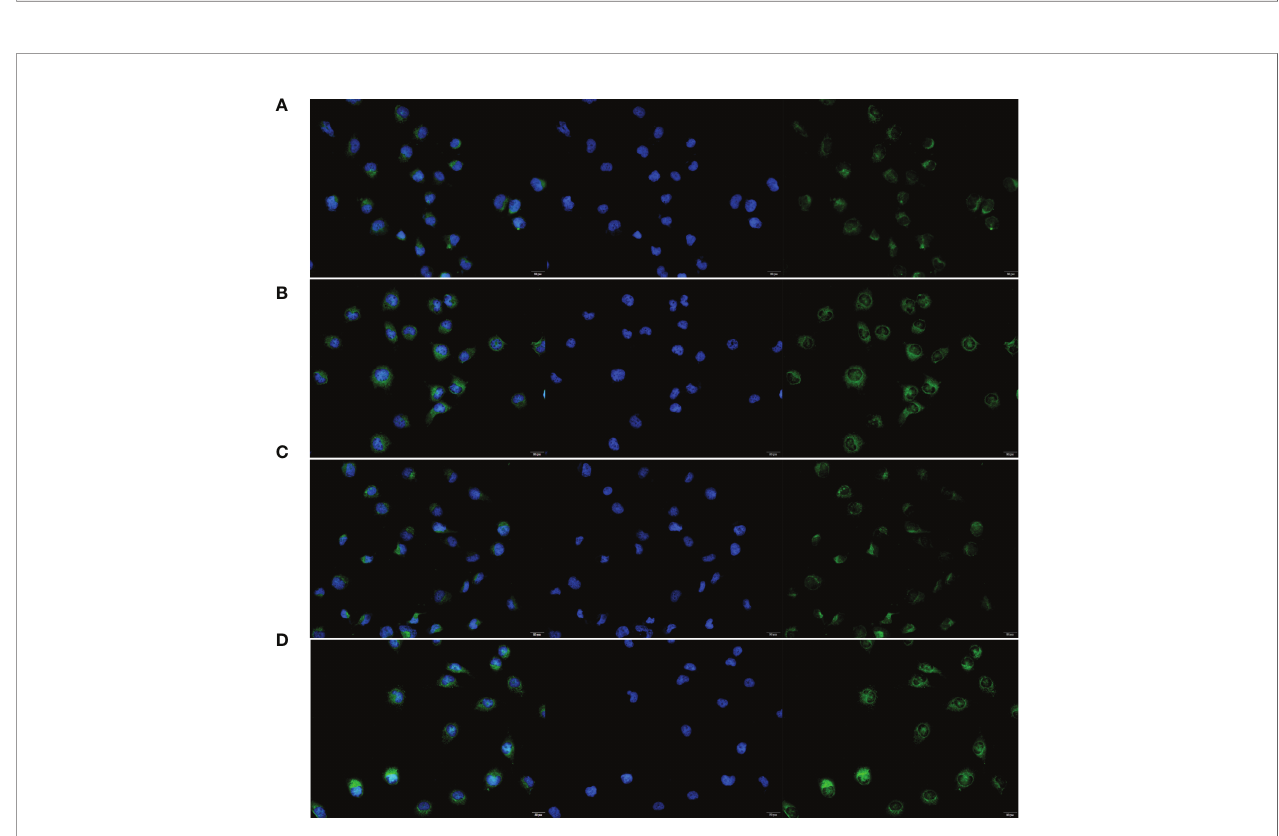
FIGURE 9 | The subcellular localization of LINC00174 and NKILA between NCM460 and HT29 cells. (A) Subcellular localization of LINC00174 in NCM460 cells. (B) Subcellular localization of LINC00174 in HT29 cells. (C) Subcellular localization of NKILA in NCM460 cells. (D) Subcellular localization of NKILA in HT29